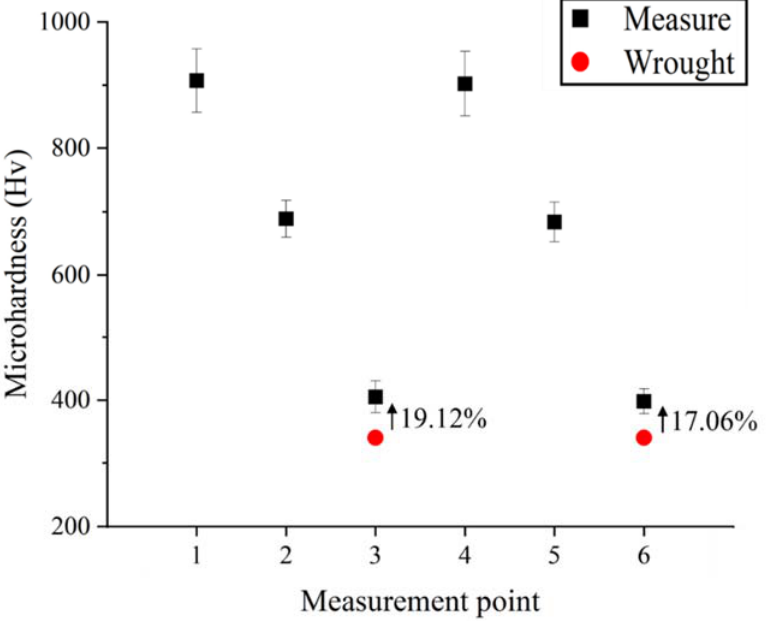
Figure 11. The microhardness distributions of Ti-Nb-Cr-V-Ni-Al deposited on the